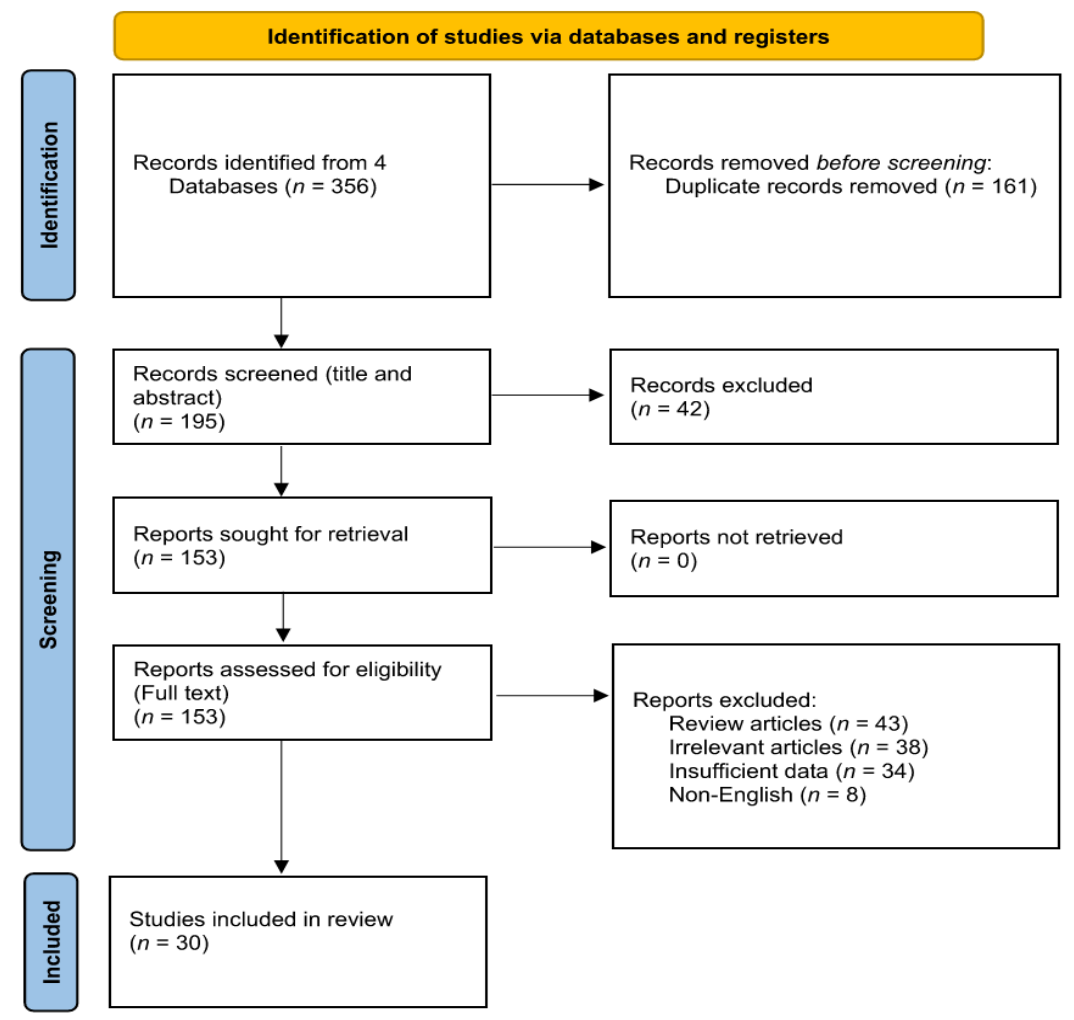
Figure 1. flowchart of the included studie. Figure 1. Flowchart of the included